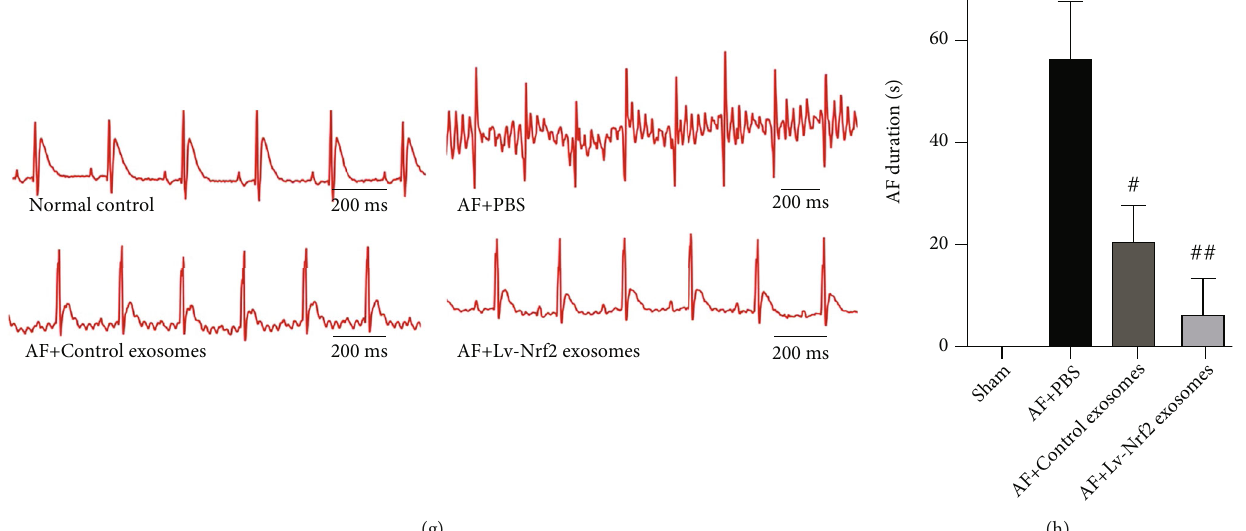
Figure 3: Lv-Nrf2 exosomes thwarted cardiac arrhythmias within AF rats. AF was established in rats using calcium chloride-acetylcholine (CaCl -Ach) mixture via tail vein injection once per day, for seven consecutive days. The normal control group was intravenously treated 2 with equivalent volume of 0.9% saline through the tail vein. Then, the exosomes derived from the control BMSCs or Lv-Nrf2 BMSCs were injected once a week to AF rats, and the CaCl -Ach solution was continued to be injected into the tail vein every 3 days for 3 weeks, while the 2 AF control group was treated with the equivalent level of PBS. (a) PKH26-labeled exosome distribution within the myocardium. Scale = 50 μ m . (b) The representative immunohistochemical stain showing the Nrf2/HO-1 cardiac expression within rats. Scale = 100 μ m . (c, d) Quanti fi cation for percentage positive Nrf2 (c)/HO-1 (d) staining area. (e) Representative Western blot imaging for Nrf2/HO-1 proteins involved within rat myocardial tissue across di ff erent groups. (f) Densitometric quanti fi cation showing the (e) relative proteomic expression normalized against GAPDH. (g) Changes in the electrocardiogram of each group were detected. (h) AF duration of each group was measured. n = 5 in each group. Results are presented as mean ± SD . ∗ P < 0 : 05 , ∗∗ P < 0 : 01 in comparison to the control group. # P < 0 : 05 , ## P < 0 : 01 in comparison to the AF+PBS